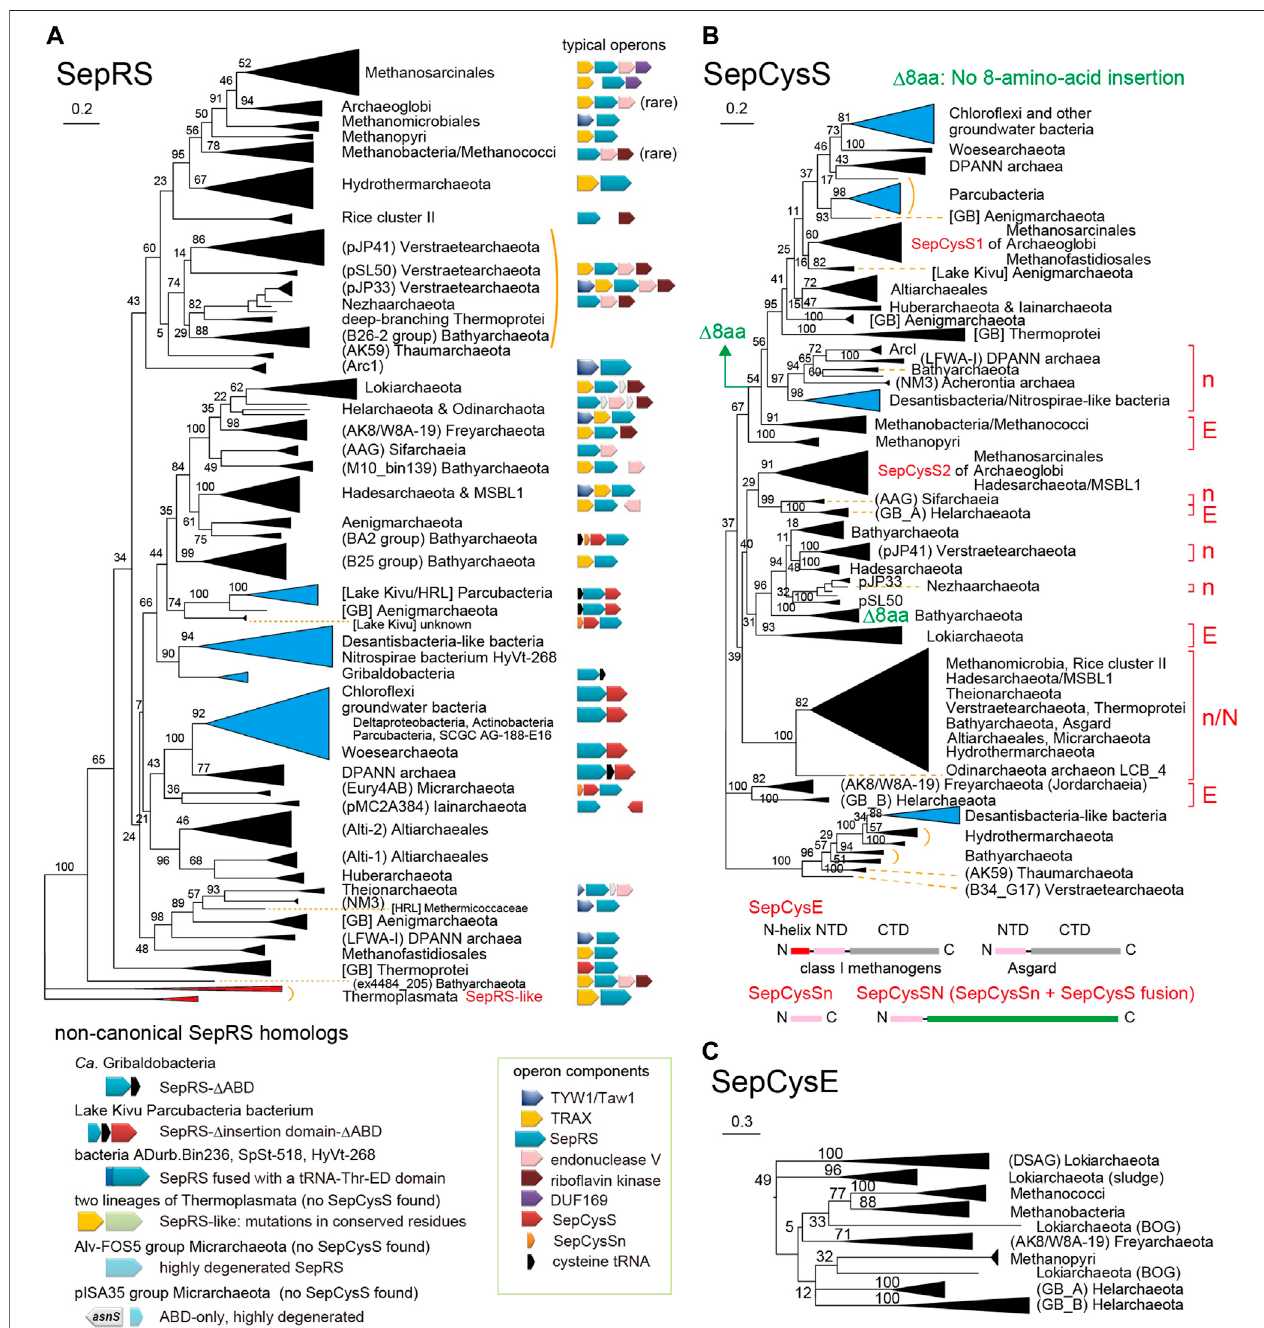
FIGURE 4 | Phylogenetic trees of SepRS (A) , SepCysS (B) , and SepCysE (C) (updated from Mukai et al., 2017a). These unrooted trees were made by maximum likelihoodestimationwith100replicates.Thebootstrapvalues(percentages)areshown.TheSepRSandSepCysScladesconsistingoforcontainingbacterialhomologs arepresentedwithbluetriangles.IntheSepCysStree,geneticassociationofSepCysSwithSepCysE(E)orSepCysSn(n)orfusionwithSepCysSn(N)areindicated.The lack of the eight-amino-acid insertion near the catalytic site of SepCysS species (Mukai et al., 2017a) is speci fi ed by green arrows. For simplicity, the interim taxonomic status for uncultured prokaryotes is not denoted with “ Candidatus ” and “ Ca. “ . In some cases, metagenomic origins (Lake Kivu, HRL, activated sludge, BOG ECP12_OM1, and Guaymas Basin) are